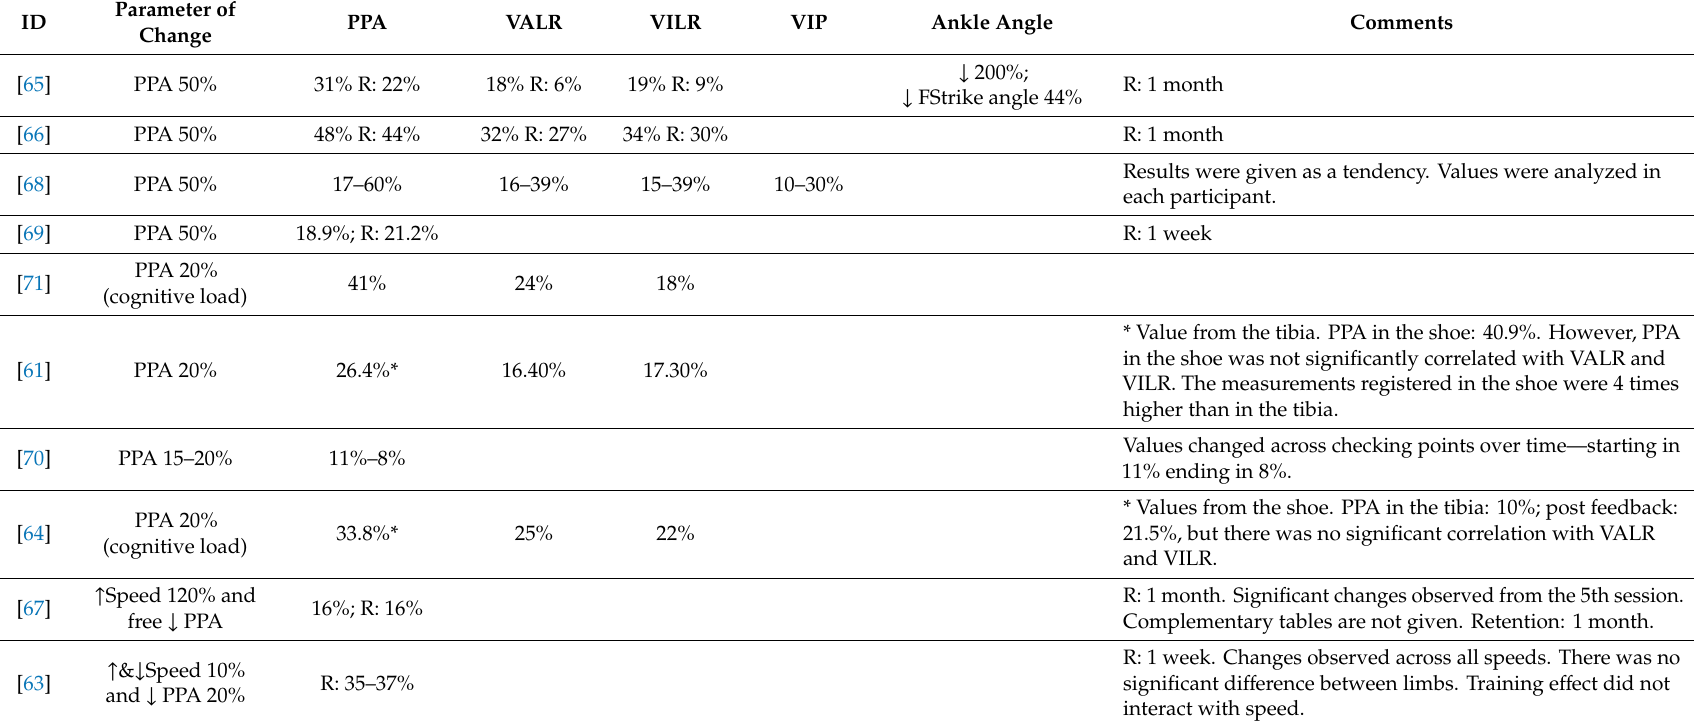
Table 5. Biomechanics changes produced by articles that provided feedback based on